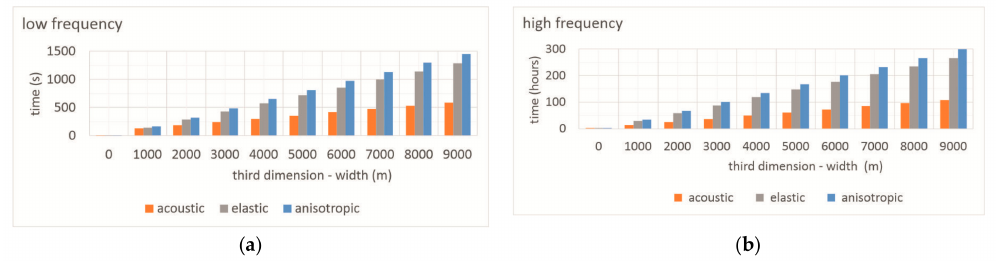
Figure 16. The execution time computed for di ff erent model sizes for: low ( a ) and high ( b ) frequencies of the source